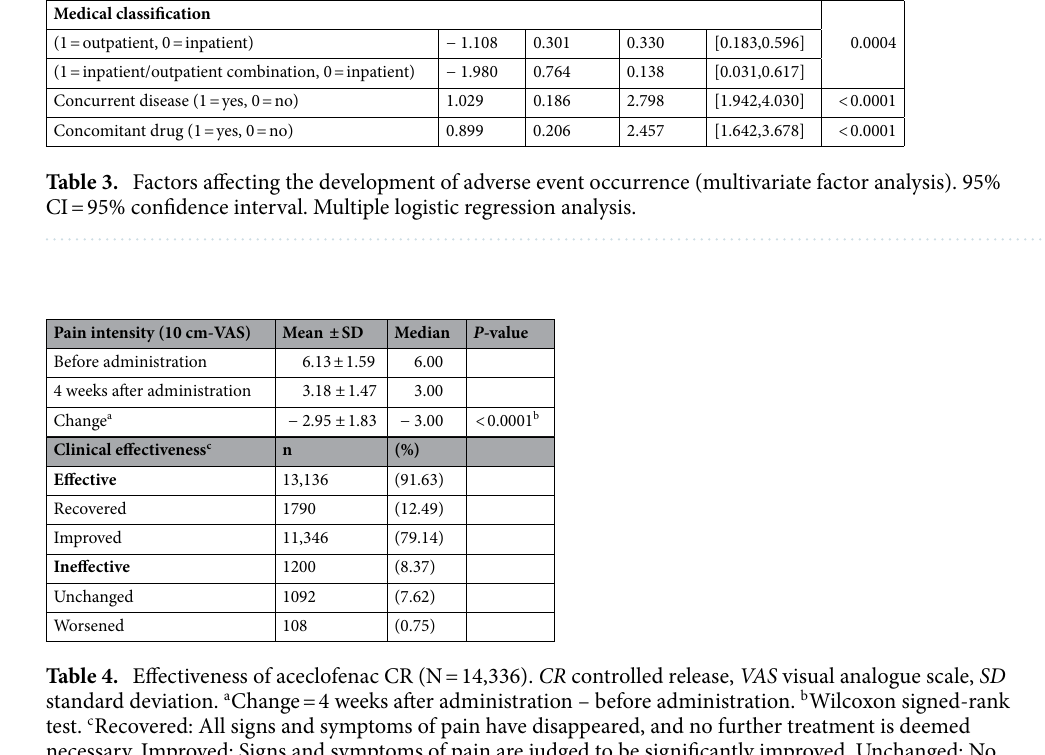
Factor Estimate Gender (1 = male, 0 = female)